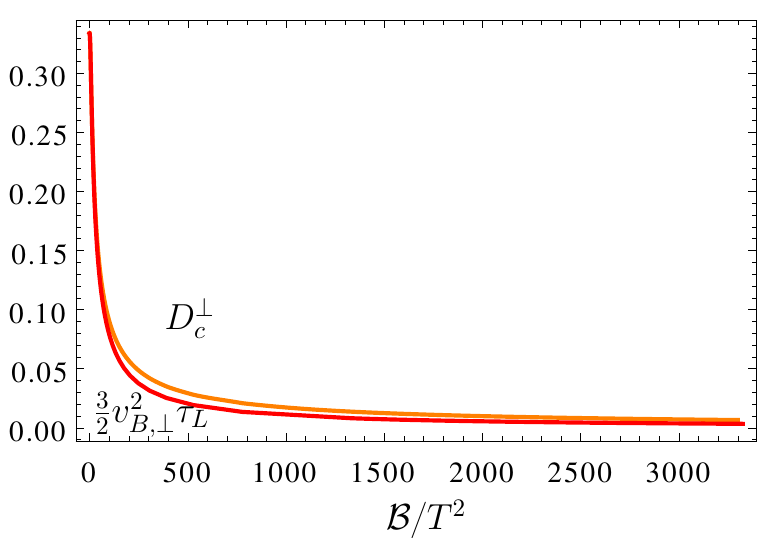
Figure 13 . Electric di(cid:11)usivity D ? dimensionless parameter